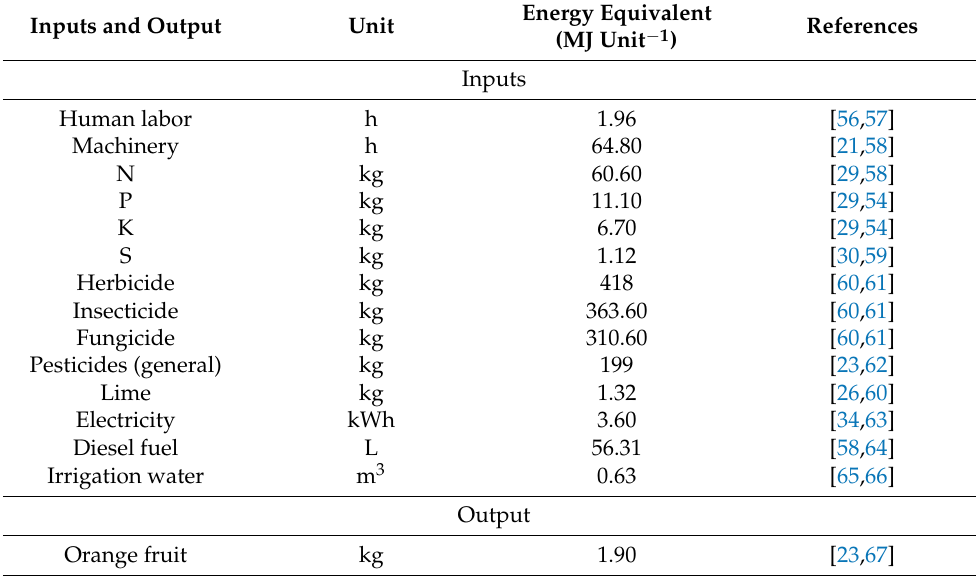
Table 1. Energy equivalents in the production of oranges.